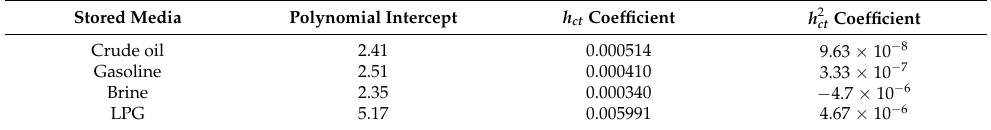
Table A1. The values of the Formula (A7) coefficients for stored liquid media of different densities. Stored Media